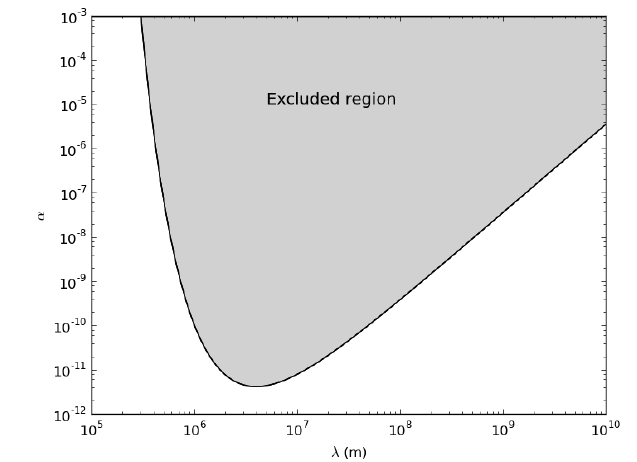
Figure 2. Hypothetical constraint on a Yukawa interaction set by a secular signal on the METRIC pericenter of 6.93 × 10 − 3 arcsec y − 1 . The upper, grey area would be excluded by this